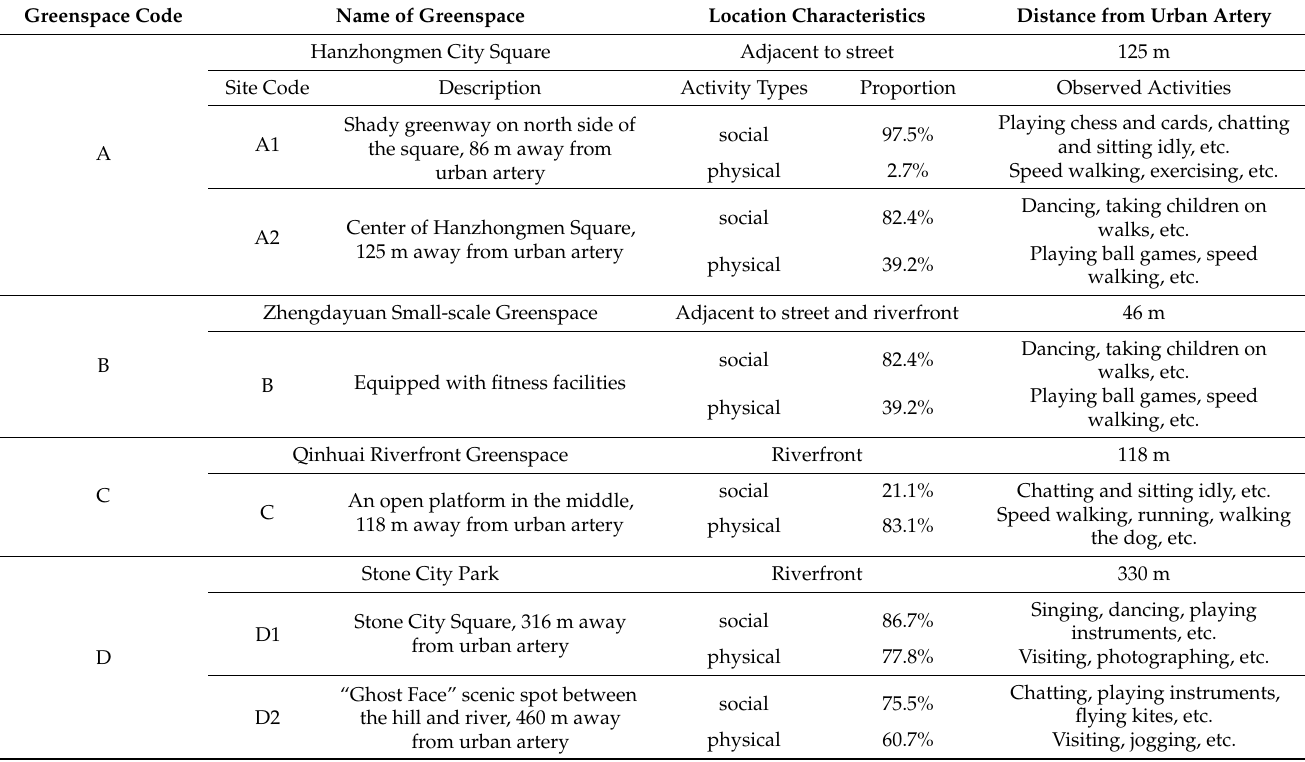
Figure 2. Site photos. ( A1 ) Shady Greenway ( A2 ) Center of the Square ( B ) Zhengdayuan ( C )Waterfront platform ( D1 ) Stone City Square ( D2 ) “Ghost Face” scenic spot. Table 1. Research site data and observed